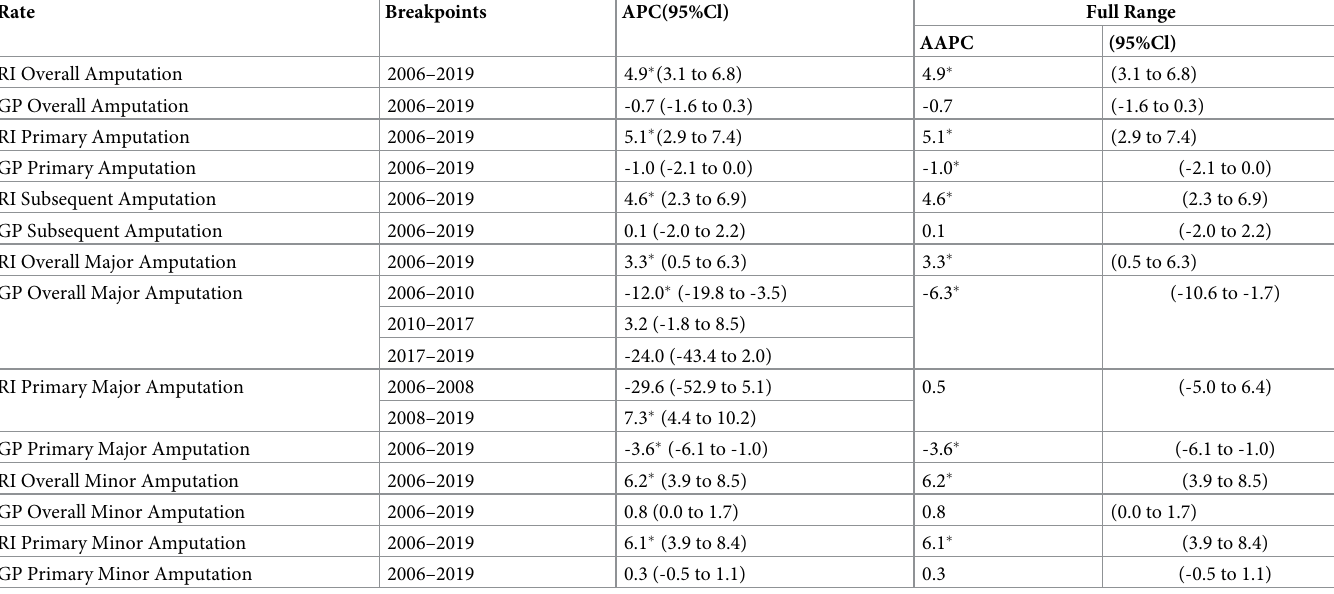
Table 2. Annual percent change in registered Indians and general populations amputation rates,